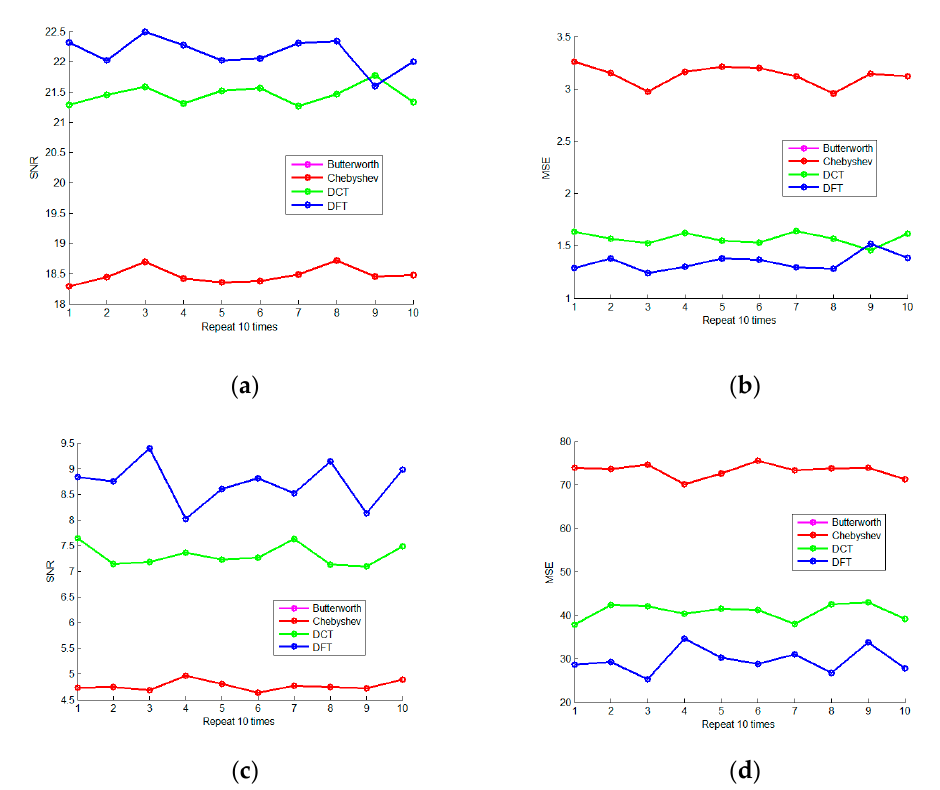
Figure 6. The Repeated Denoising Experiment ( a ) is the 10-times repetitive SNR curve of four de- noising methods when sigma is 2; ( b ) is the 10-times repetitive MSE curve of four denoising methods when sigma is 2; ( c ) is the 10-times repetitive SNR curve of four denoising methods when sigma is 10; ( d ) is the 10-times repetitive MSE curve of four denoising methods when sigma is 10. Change the sigma from 1 to 10 in sequence, as shown in Figure 7. It can be seen that the OMP sparse representation method based on the DFT dictionary has the best denoising effect and stable performance; the OMP sparse representation method based on the DCT dictionary has a modest effect, but it is relatively stable.